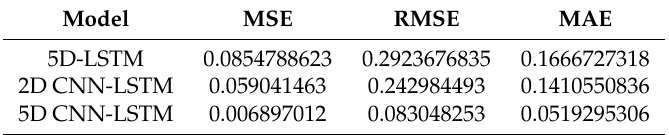
Figure 12. Prediction of PV generation during rainy days. Table 2. Performance comparison of the proposed model with other deep learning models.